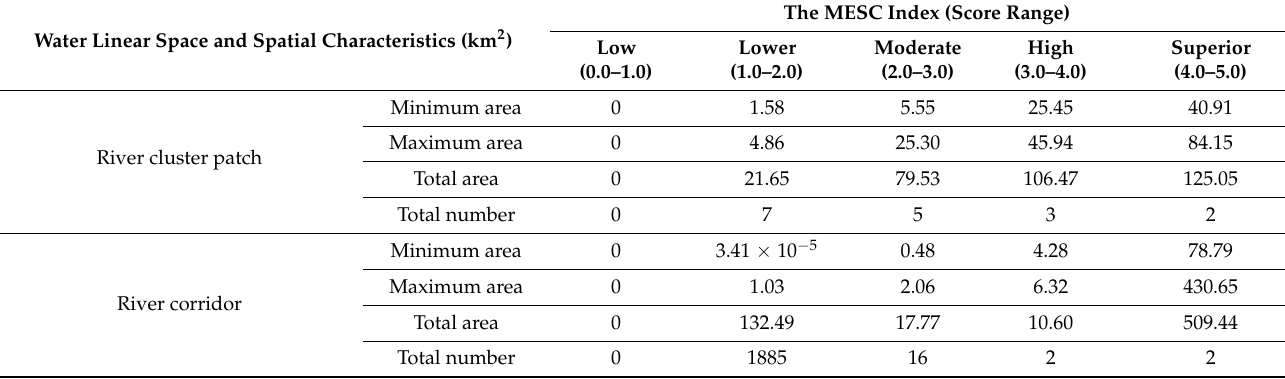
Table A6. Statistical results of the MESC index of water linear